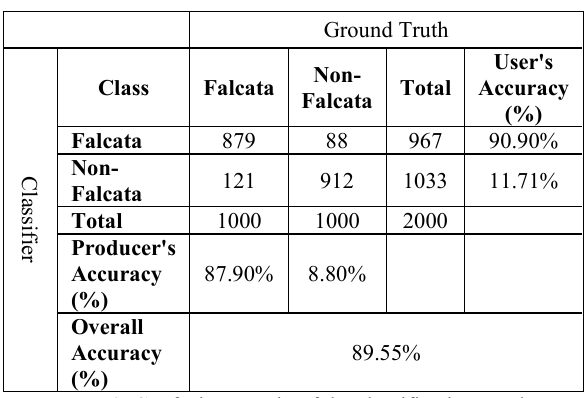
Table 3. Confusion Matrix of the classification